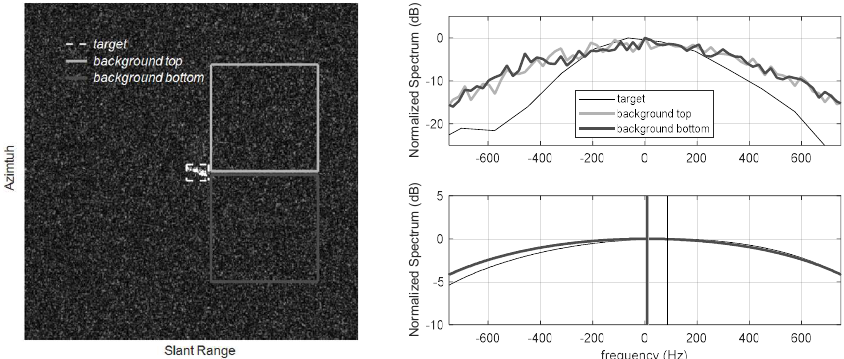
Figure 5. Ship velocity estimation procedure based on the Doppler centroid (DC) analysis: ( left ) selected target and background boxes, ( top right ) spectra resulting from incoherent summation, and ( bottom right ) fitted spectra with computed centroids as vertical lines.